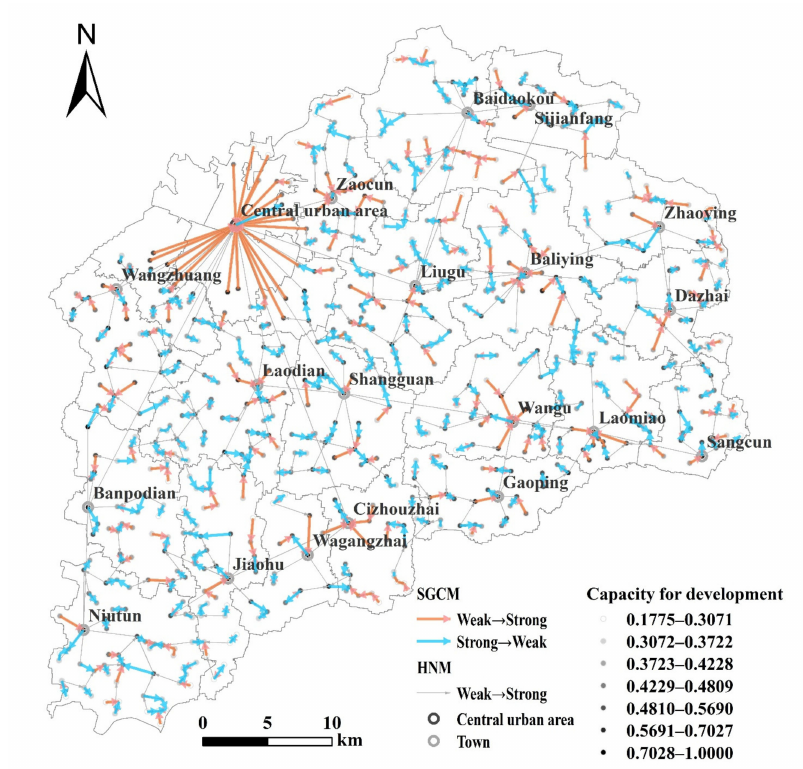
Figure 10. Identification of the spatial structure of urban and rural settlements in Hua County based on the strongest gravitational connection